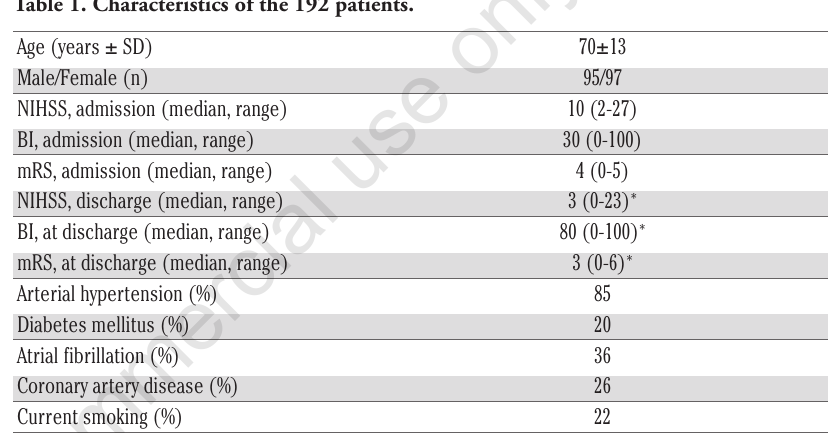
Table 1. Characteristics of the 192 patients.